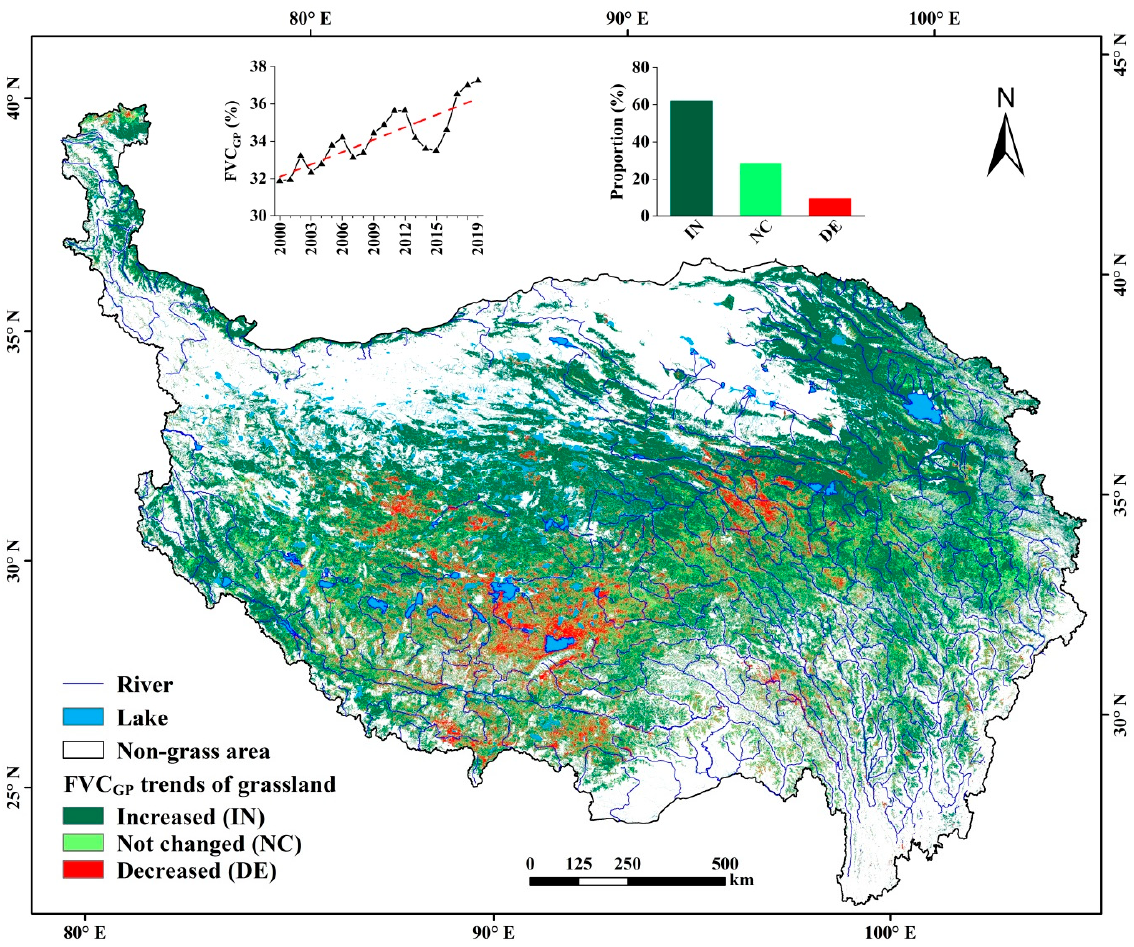
Figure 3. Spatial distribution of trends in the FVC GP of grasslands during 2000–2019.